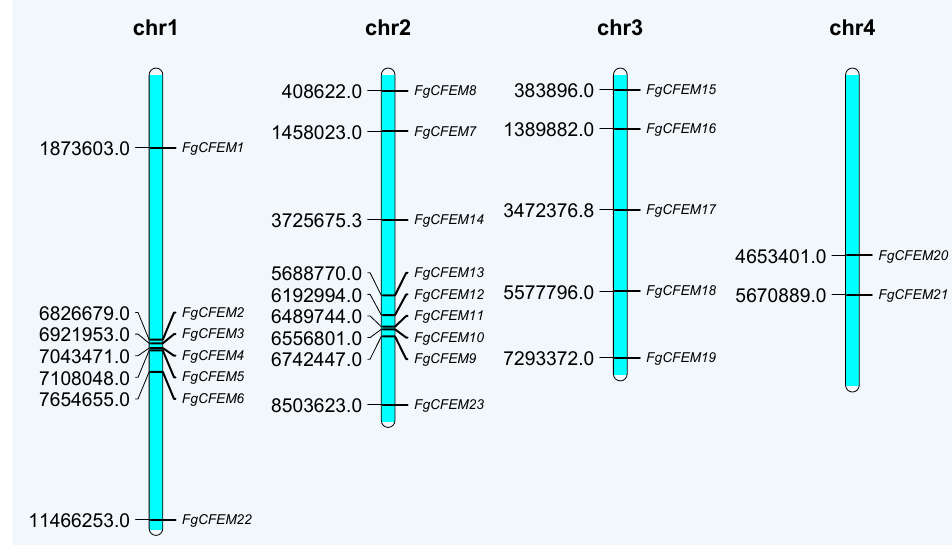
Figure 3. Mapping of the CFEM genes on F. graminearum (strain PH-1) chromosomes.